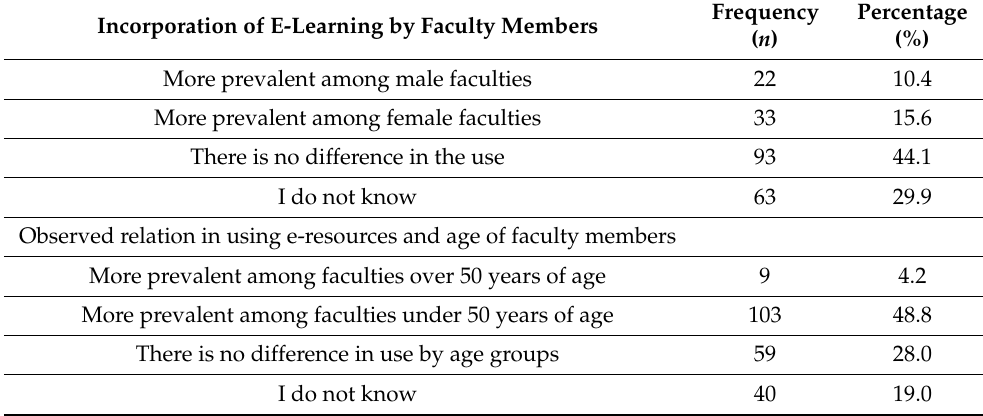
Table 4. Students’ observations of incorporation of e-learning by faculties and the age of faculties.